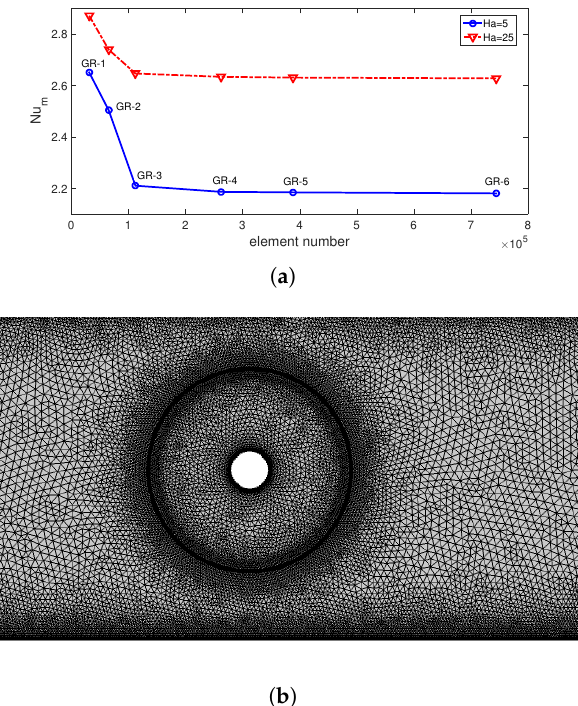
Figure 2. Grid independence test. Average Nu for different grid sizes at two different MaF strength levels ( a ) and mesh distribution of the SJ-I with NPO ( b ) (Rew = − 600, Da = 5 × 10 − 2 , Mx = − 1, AR =